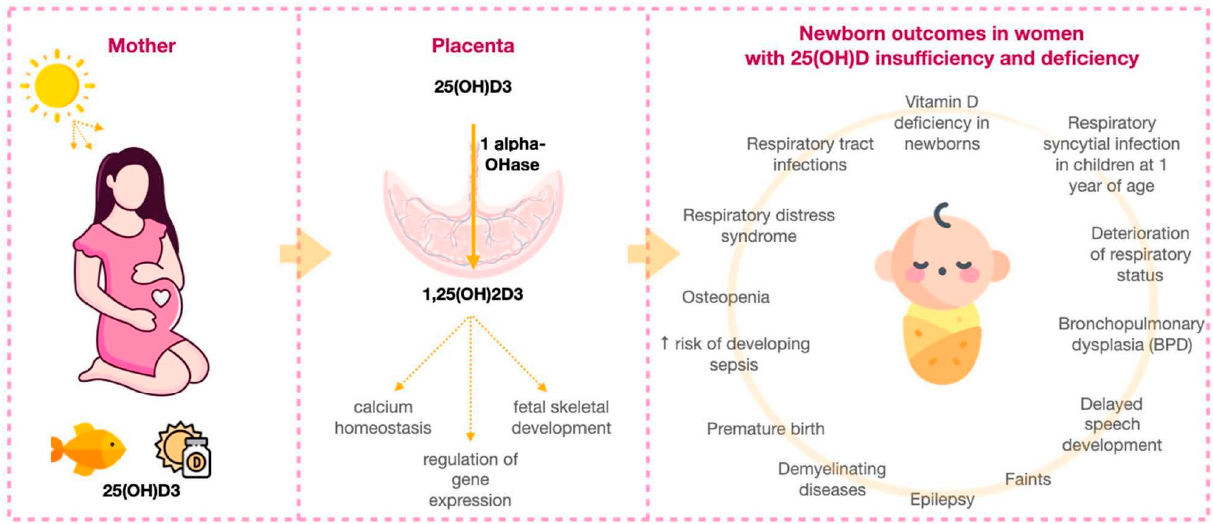
Figure 1. Neonatal outcomes in conditions of maternal 25(OH)D insufficiency and